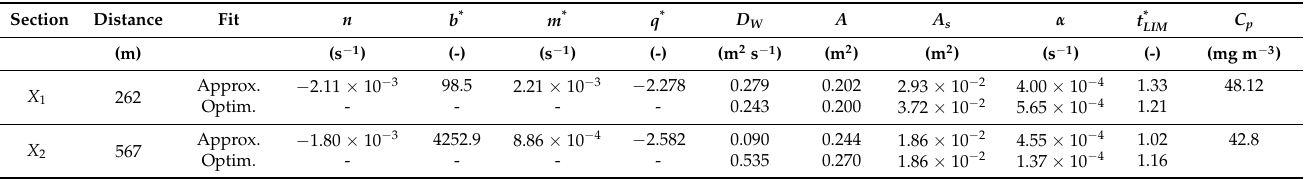
Table 2. Coefficients m ∗ , q ∗ , b ∗ , n of the approximation trendlines in Figure 3; TSM parameters A , A S , D W , α obtained from the trendline approximations (“Approx.”) and from a numerical optimized fit (“Optim.”) of the BTCs; estimation of t ∗ for each section and type of fitting, and peak concentration LIM C p at each section used for normalizing the BTC in Figure